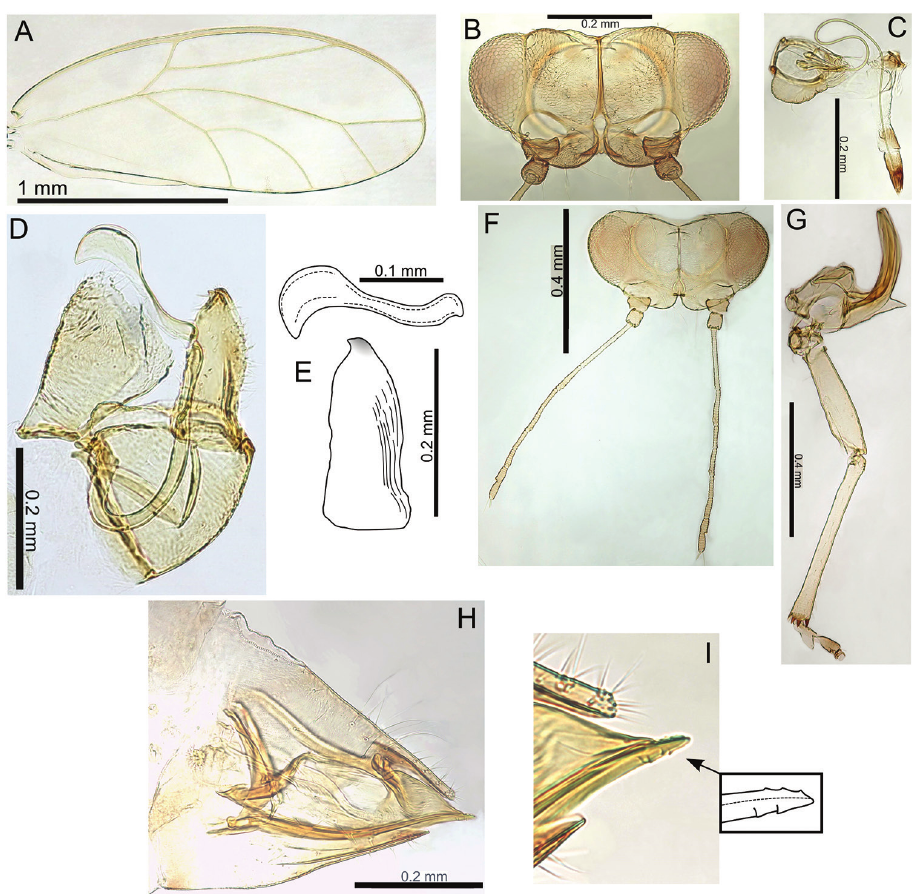
Figure 27. Pariaconus lehua . A fore wing B head C proboscis D male terminalia E aedeagus and para- mere F head and antennae G hind leg H female terminalia I ovipositor (serrations indicated).